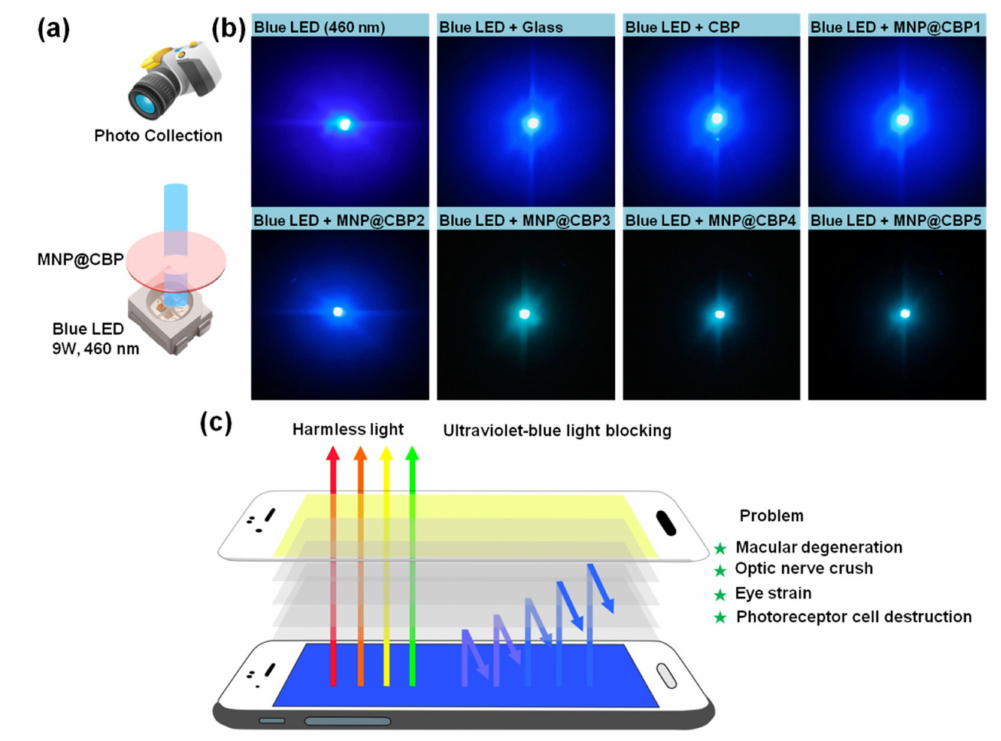
Figure 10. ( a ) Schematic of the experimental setup, ( b ) photographs of blue LED and its blocking effect covered by glass, CBP and MNP@CBPs. ( c ) Schematic diagram of MNP@CBP applied in a mobile phone screen protector.